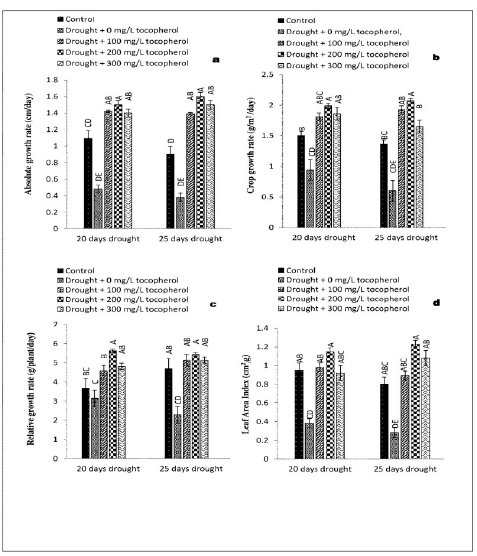
Fig 1. Effect of varying levels of exogenously applied α -tocopherol on absolute growth rate ( a ) crop growth rate ( b ) relative growth rate ( c ) leaf area index ( d ) of lentil ( Lens culinaris Medik.) grown under varying drought stress condition (Mean ± standard error.) letters (A–E) indicating least significance difference among the mean values at p � 0.05.